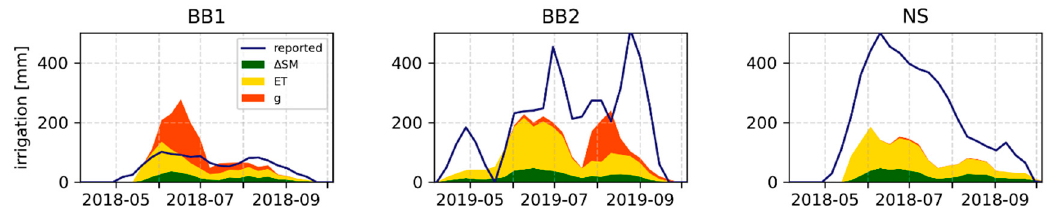
Figure 7. Time series of spatially cumulated irrigation water heights, aggregated on a weekly basis. Estimated irrigation, with the explicit contribution of each term to the total, is compared against reference data reported by farmers.